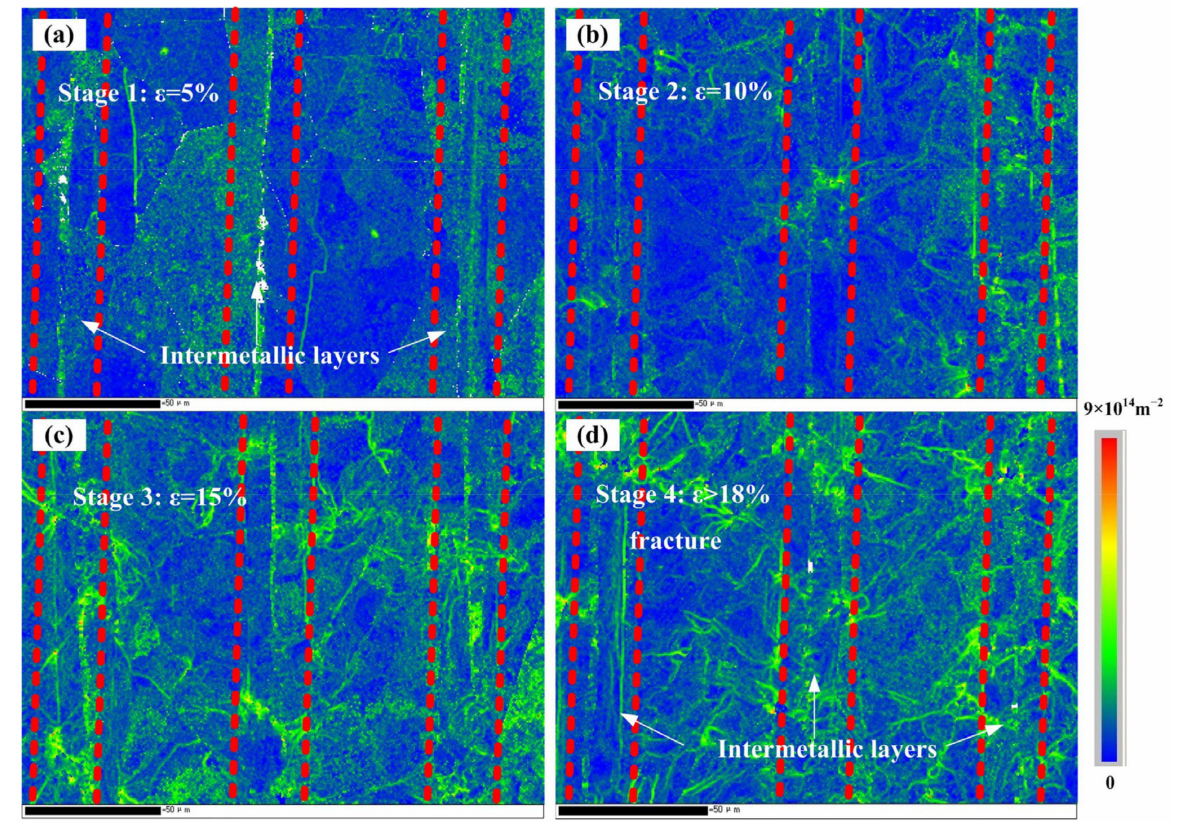
Figure 10. GND density maps of laminated composites after tensile deformation at 900 ◦ C and 0.001/s with true strain of: ( a ) 5%; ( b ) 10%; ( c ) 15%; ( d ) fracture